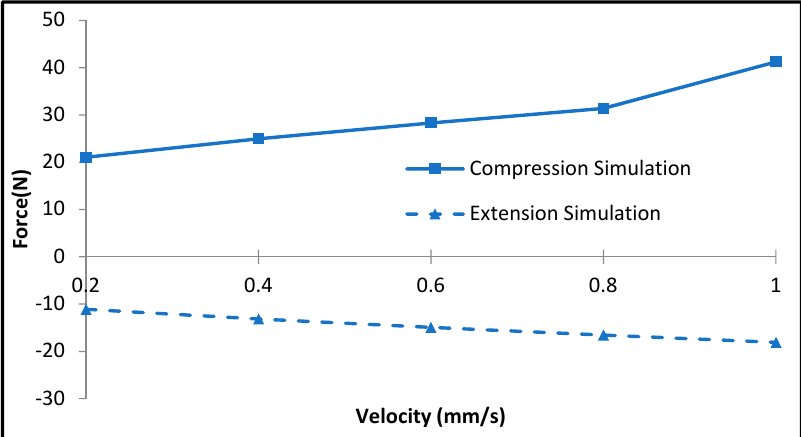
Figure 8. Relationship between magnetic field strength and current input in the MR damper.